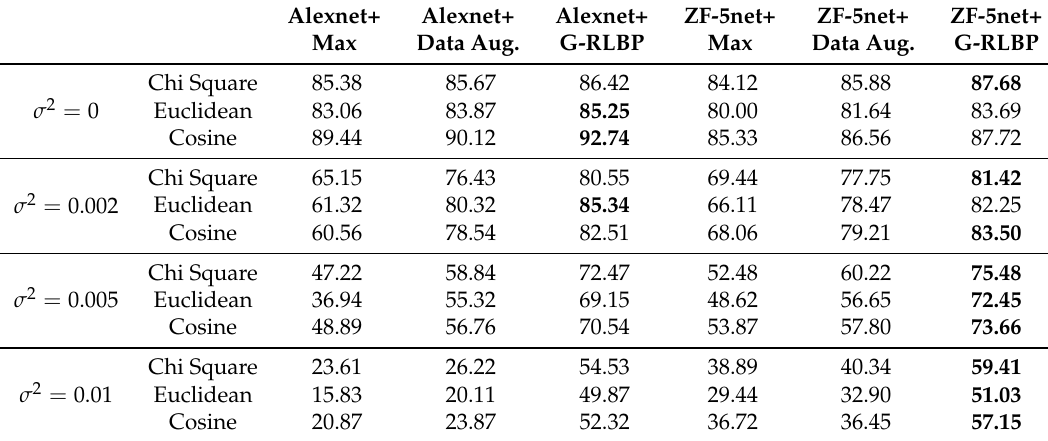
Table 3. The recognition rates (%) of different pooling methods and data augmentation based on the Alexnet and ZF-5net on the ORL database with different Gaussian noise.